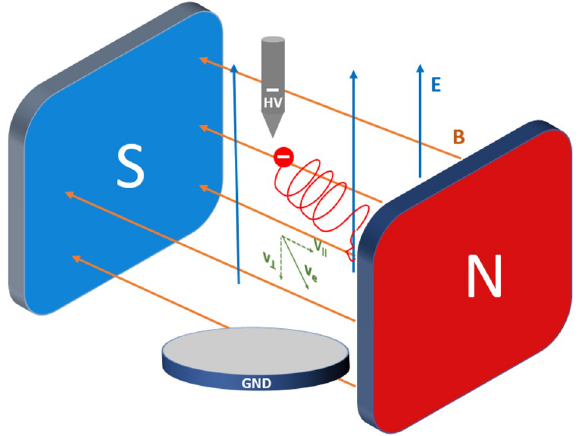
Figure 1. Visualization of particle trajectory in crossed magnetic B and electric E